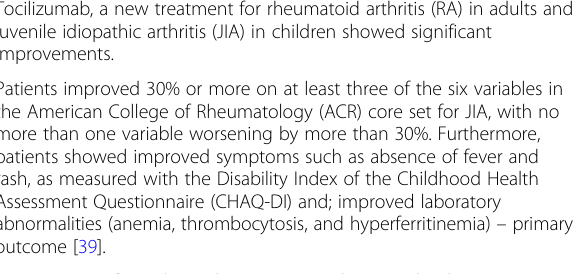
Table 4 Impact of PRO trial data: a practical example Tocilizumab, a new treatment for rheumatoid arthritis (RA) in adults and juvenile idiopathic arthritis (JIA) in children showed significant